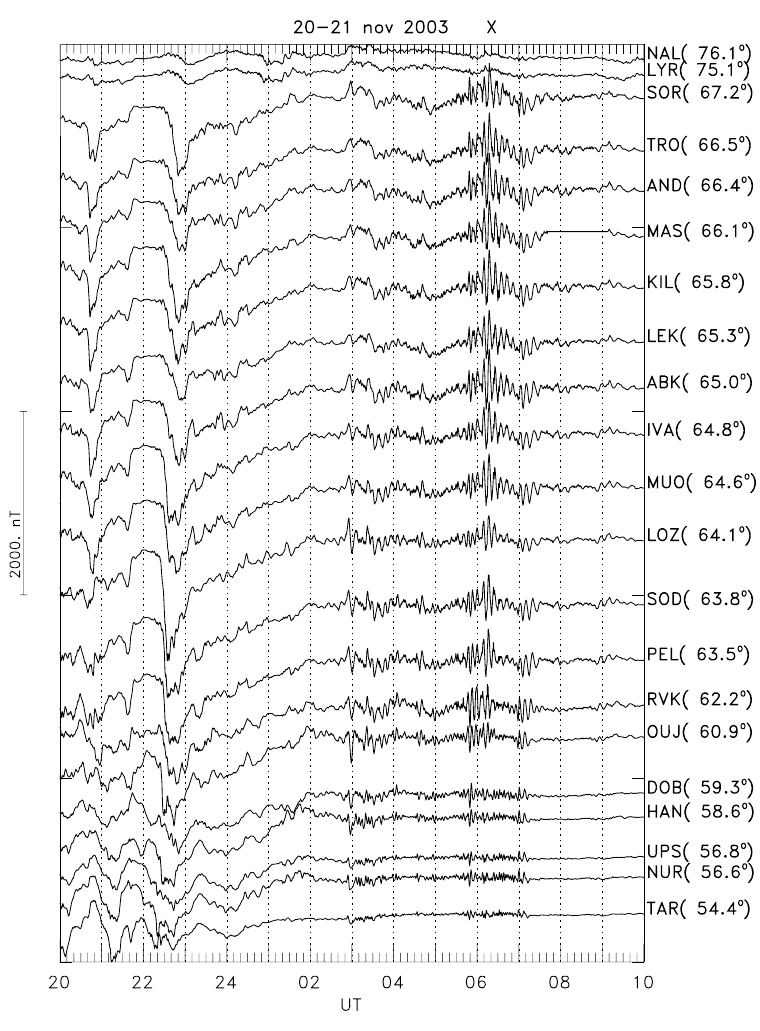
Fig. 2. IMAGE magnetometer data (X component) during the recovery phase of the magnetic storm on 20–21 November 2003. The codes of the stations and their corrected geomagnetic latitudes indicated are on the right